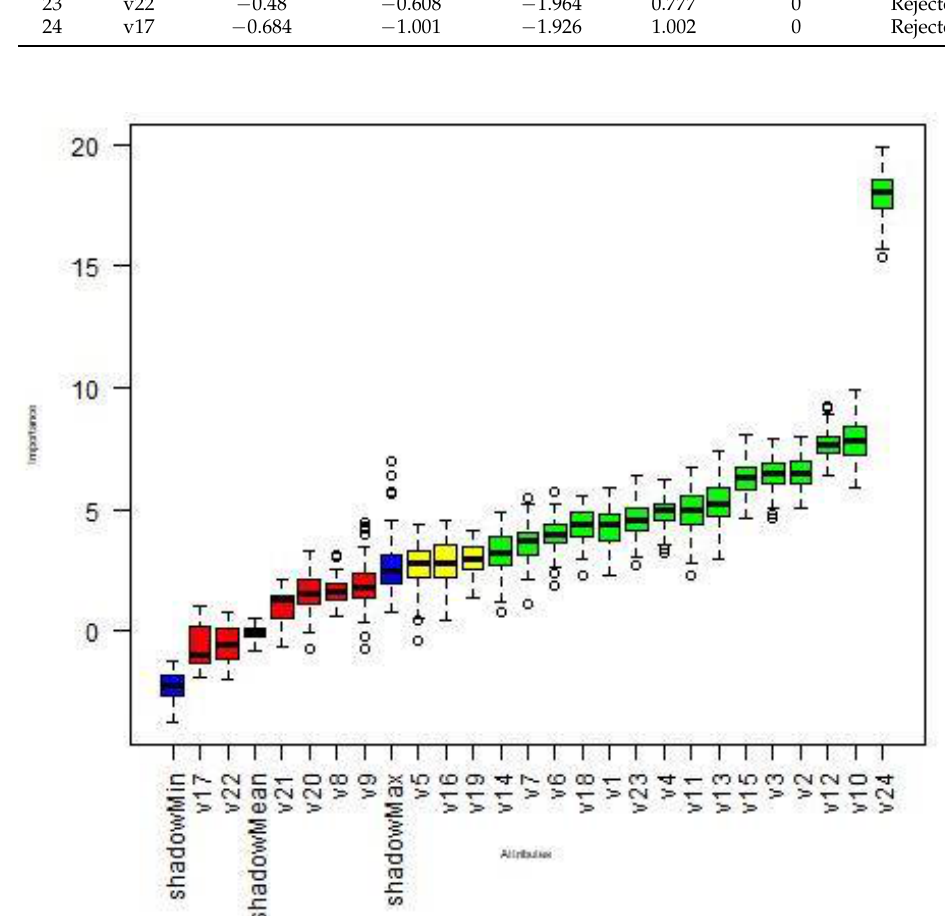
Figure 1. Feature selection importance graph using the BORUTA algorithm.